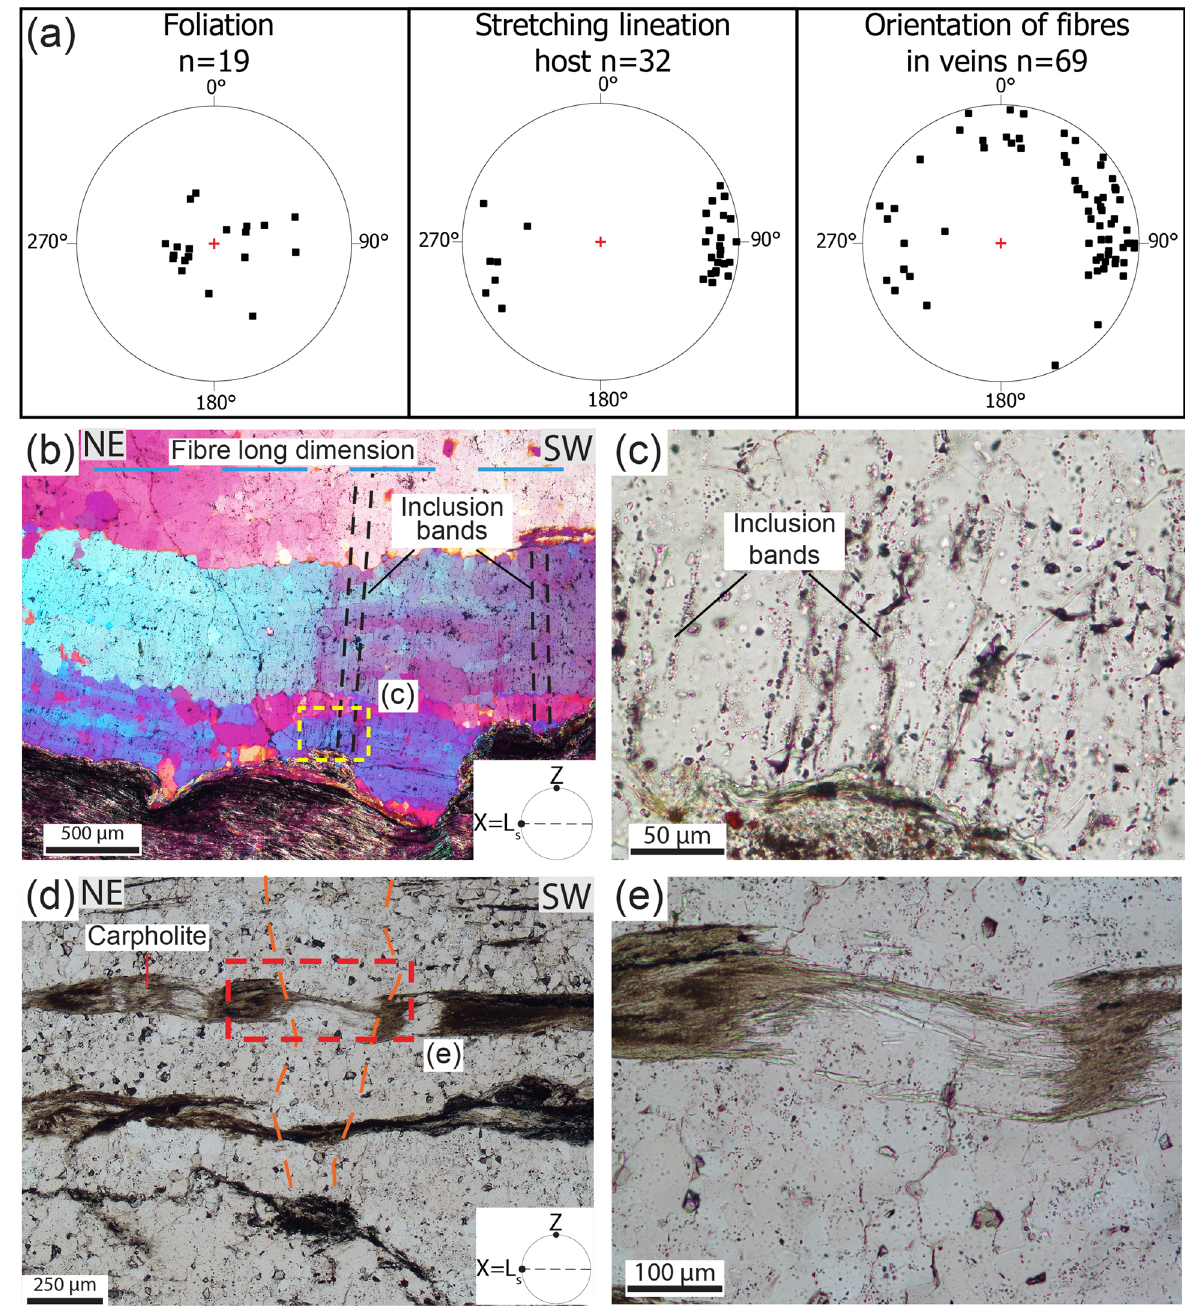
Figure 4. Stereographic projections of selected planar (poles to foliation planes) and linear fabric elements and microstructural details of dilational hydroshear vein in sample A. ( a ) Equal area, lower hemisphere stereographic projections. Poles to foliation planes, stretching lineation in metapelite, metaquartzarenite and metaconglomerates and orientation of fibres in veins. ( b ) The quartz band in dilational hydroshear vein is rich in inclusion bands (black dashed lines) oriented perpendicular to long dimension of the fibres (dashed light blue line) and vein boundaries, which indicates vein growth by incremental crack-seal (see main text). Crossed- polarized light with gypsum plate inserted. ( c ) Detail of the inclusion bands and the white mica rich in graphite and hematite inclusions (bottom part of the photo). Plane-polarized light. ( d ) Stretched and partly boudinaged carpholite fibres in dilational hydroshear vein. The boudin necks are infilled by quartz and finer grained carpholite. The boundaries of a boudin neck are marked by the dashed orange line. ( e ) Detail of a boudin neck highlighting incremental crack-sealing stages. Plane-polarized